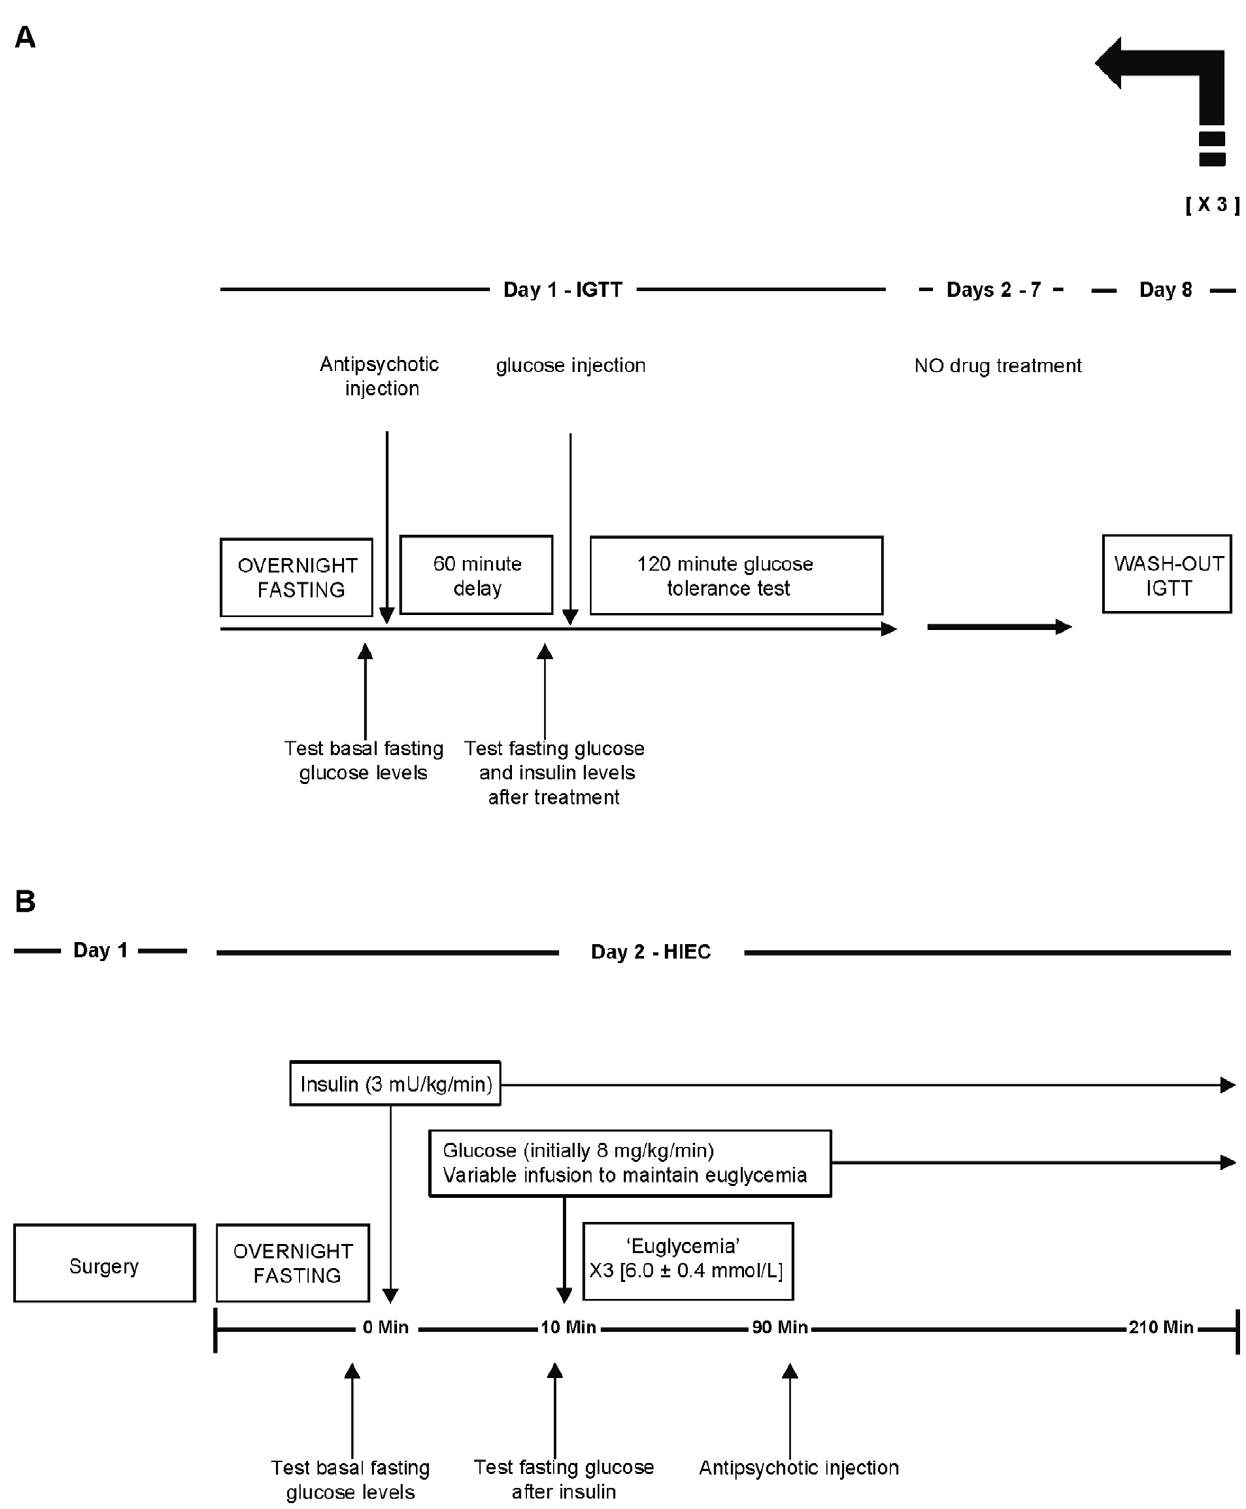
Figure 1. Experimental protocol. Describing ( A ) the intraperitoneal glucose tolerance test and ( B ) the hyperinsulinemic-euglycemic clamp with acute antipsychotic drug treatment. doi:10.1371/journal.pone.0053459.g001 heparinized saline-filled PE50 tubing, directly attached to infusion- only pumps (Harvard Apparatus, Holliston, MA). After a baseline